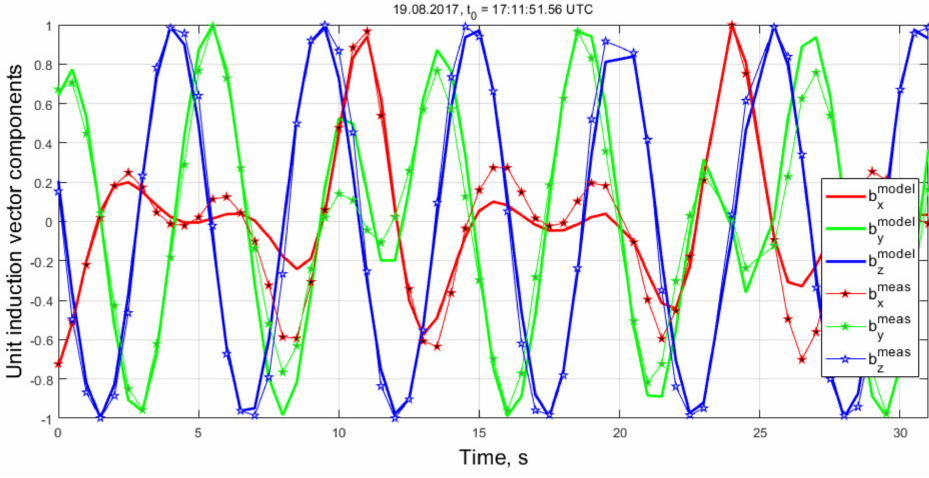
Figure 5. Measured and predicted unit vector of the geomagnetic